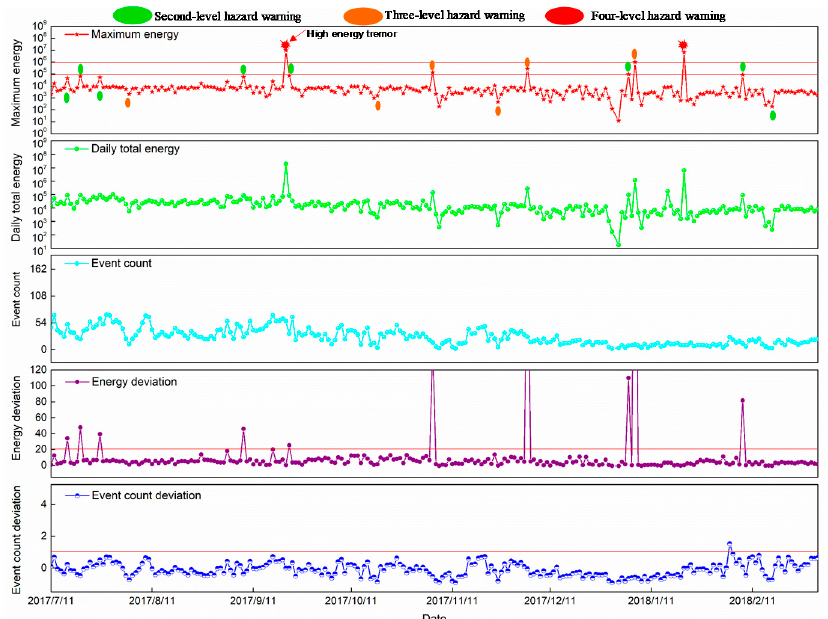
Figure 18. Early warning results of “critical value + trend” early warning method (application stage).